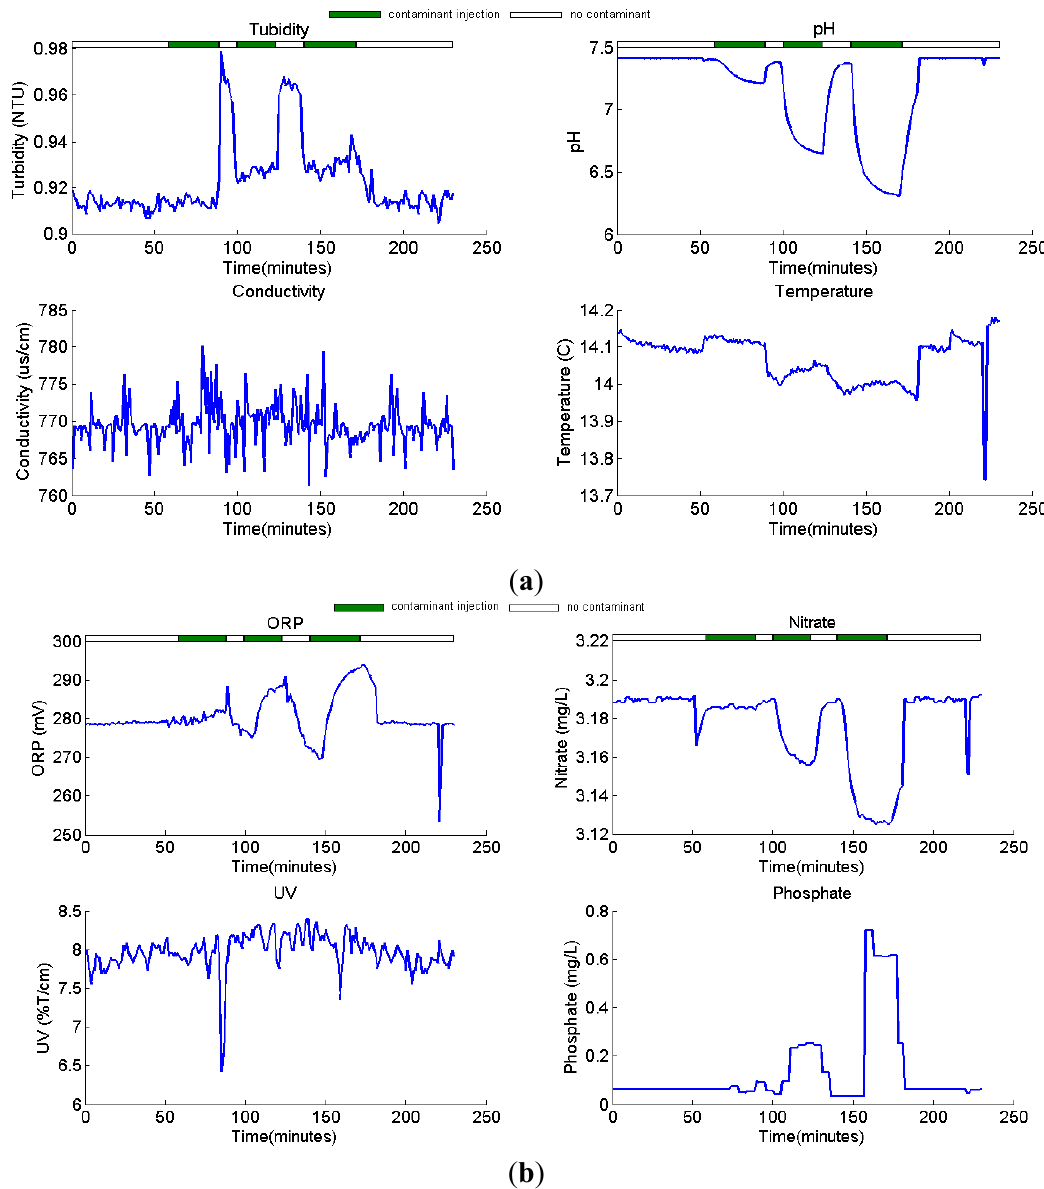
Figure 2. ( a ) Sensor responses (Turbidity, pH, Conductivity and Temperature) for glyphosate (concentrations: 0.8, 2.0, 4.0 mg/L); ( b ) Sensor responses (ORP, Nitrate, UV-254 and Phosphate) for glyphosate (concentrations: 0.8, 2.0, 4.0